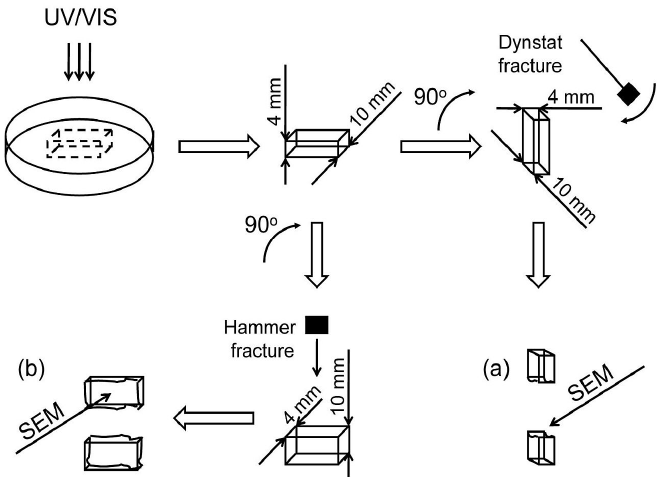
Figure 7. The representation of the fracture directions: ( a ) from impact tests, fracture surface was parallel to the direction of irradiation; ( b ) made with a hammer, fracture surface was perpendicular to the direction of